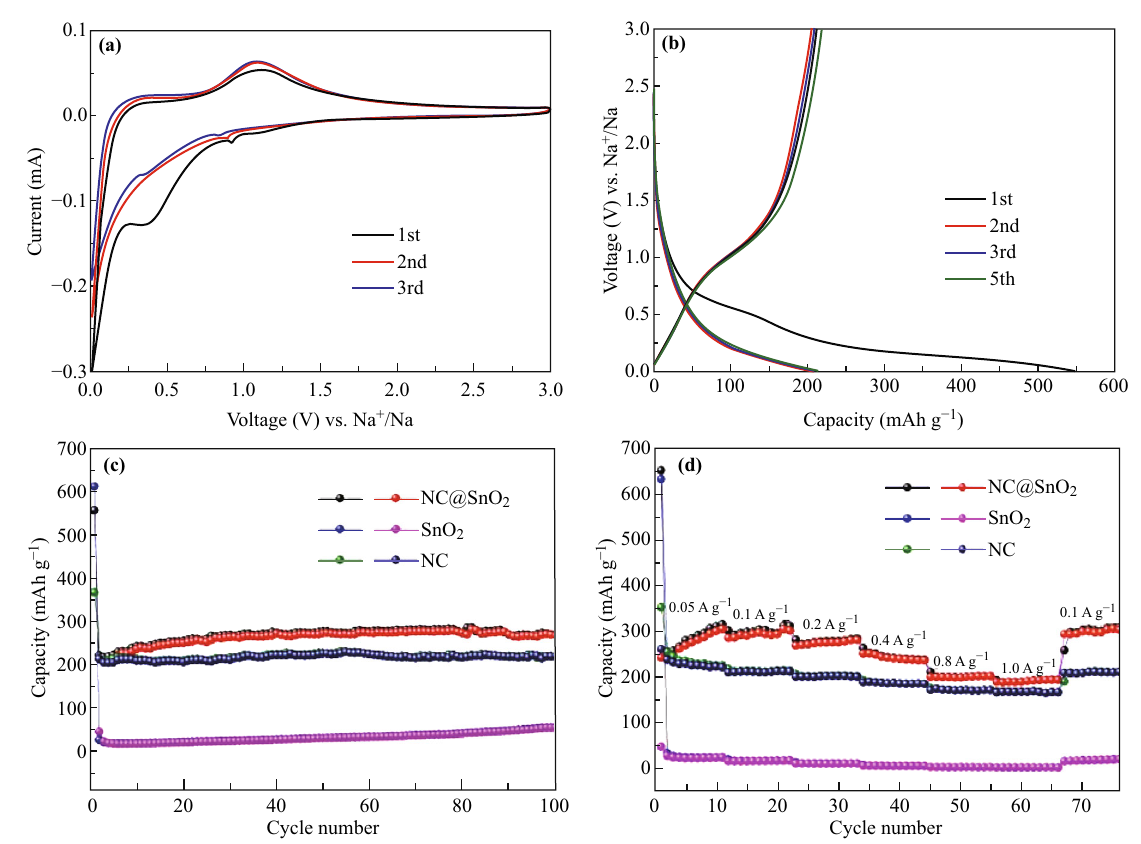
Fig. 6 Electrochemical performance for SIBs: a Cyclic voltammetry curves of NC@SnO 2 at 0.1 mV s - 1 . b Charge–discharge voltage profiles of NC@SnO 2 . c Cycling performances of NC@SnO 2 , SnO 2 , and NC at 100 mA g - 1 . d Rate capabilities of NC@SnO 2 , SnO 2 , and NC. (Color figure